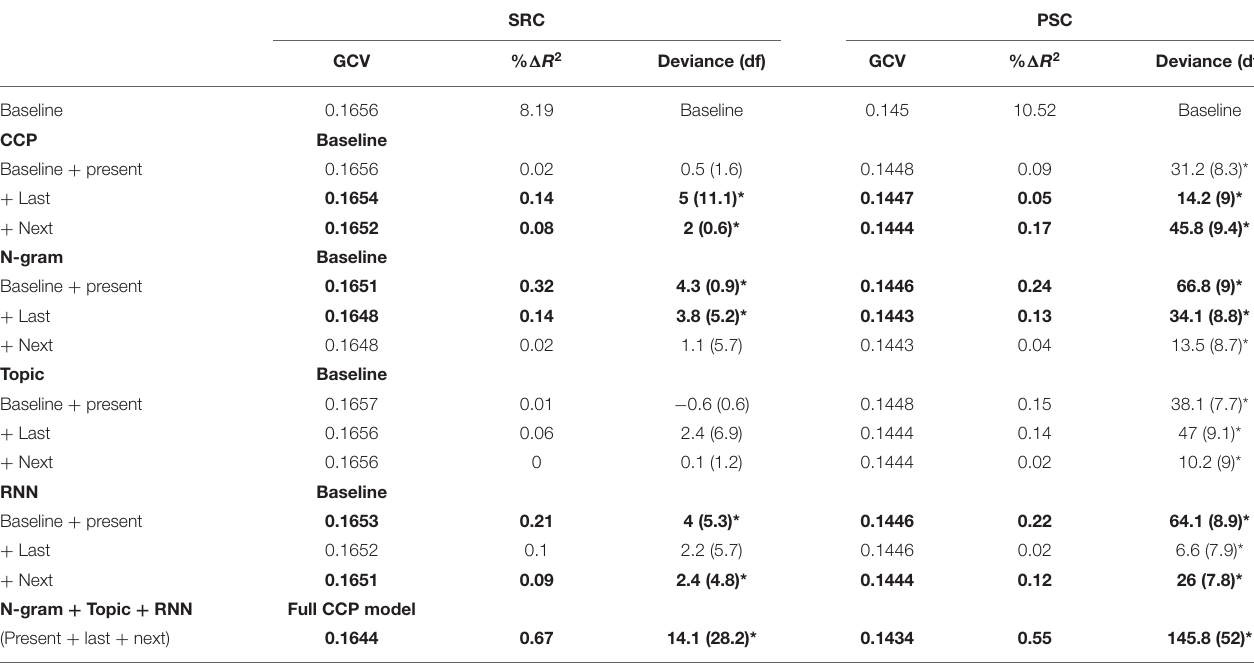
TABLE 5 | Generalized additive models (GCV, R 2 ) for gaze duration (GD) and χ 2 tests (df) against the previous model for significant increments in explained variance (* p < 0.05).